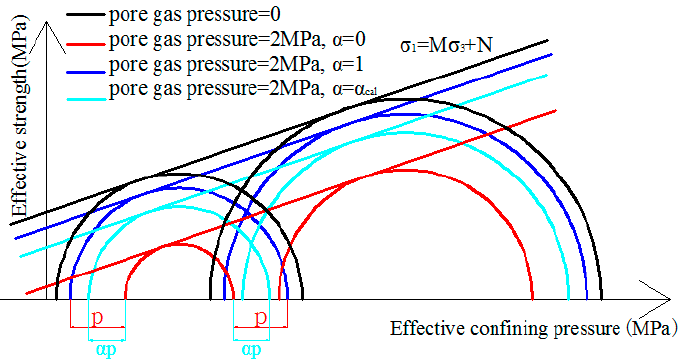
Figure 7. Schematic diagram of effect of pore methane on effective strength of gas-infiltrated shale.